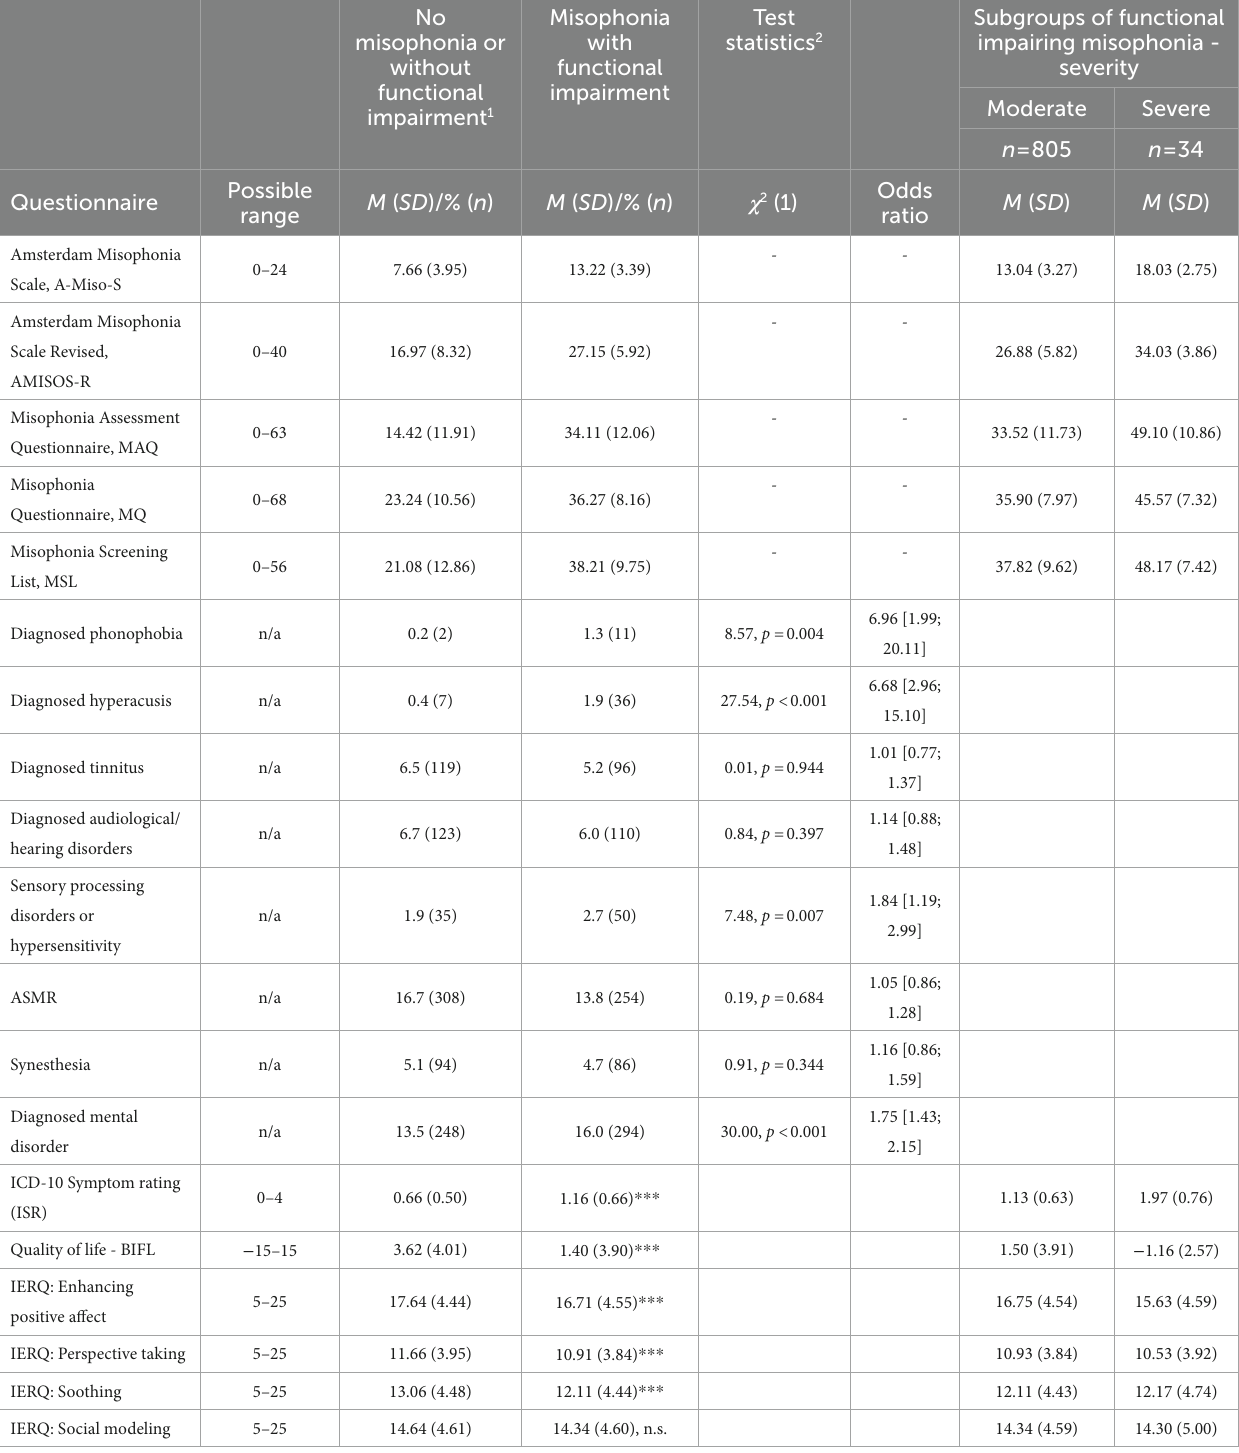
TABLE 3 Misophonia symptom severity and other characteristics in individuals without ( n = 1,042) and with ( n = 839) functional impairing